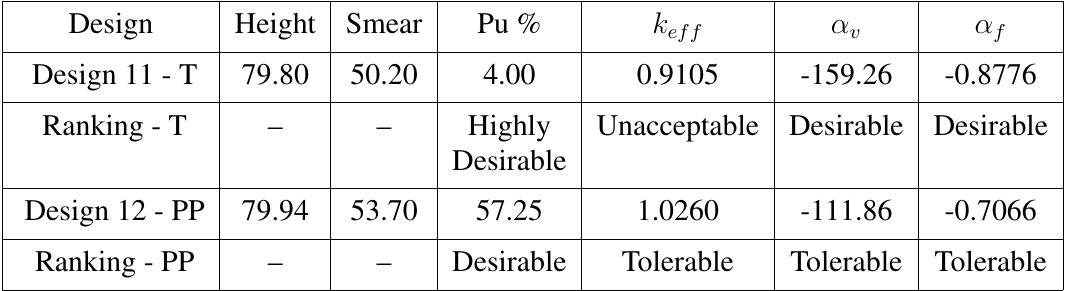
Table 8: Designs for MOGA using Weighting Scheme and Physical Programming